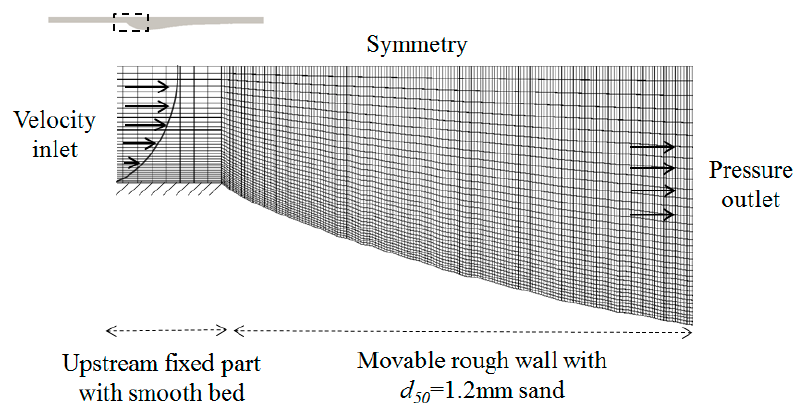
Figure 2. Schematic model setup and mesh grid (not to scale).